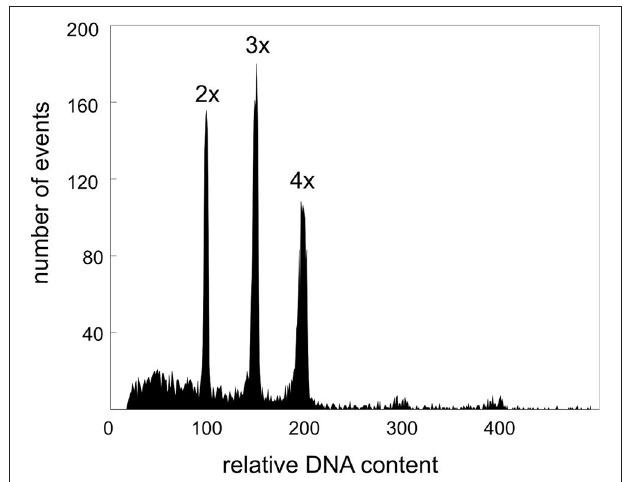
FIGURE 2 | Histogram of relative DNA content (DAPI fluorescence intensity) obtained after simultaneous analysis of nuclei isolated from diploid, triploid, and tetraploid plants collected in